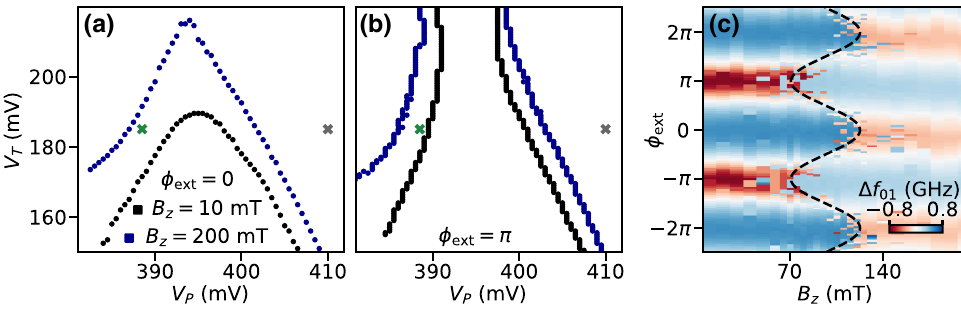
FIG. 6. The parallel magnetic field dependence. (a) The borders between the singlet and doublet regions for B z = 10 mT (black) and B z = 200 mT (blue), measured at φ ext = 0. (b) The same as (a) but for φ ext = π . The gray marker denotes the gate point used to recalibrate the flux axis after varying B z [60]. (c) (cid:9) f 01 versus B z and φ ext , measured at the gate point indicated in (a) and (b) with a green marker. The sinusoidal dashed line serves as a guide for the eye, in line with the transition boundary expected from theory